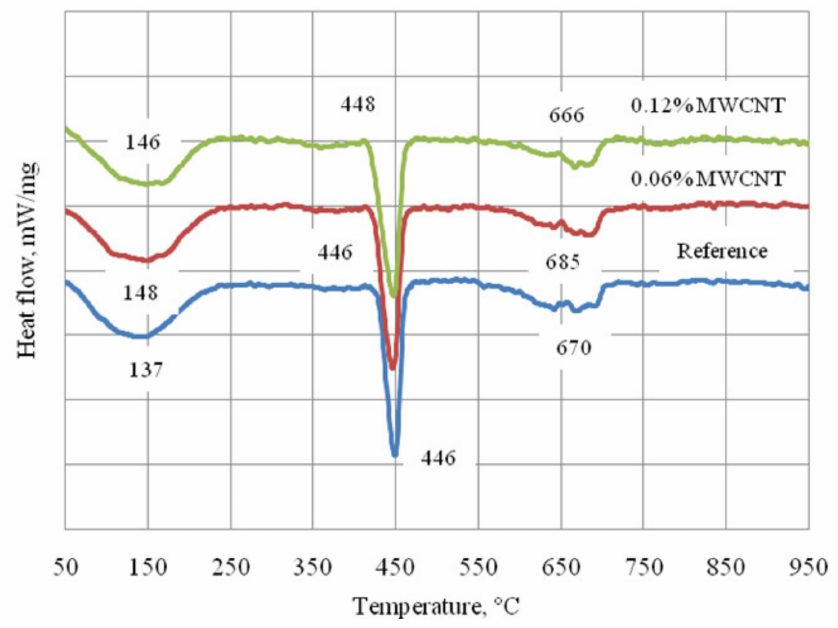
Figure 6. Differential scanning calorimetry patterns of samples with different amounts of the MWC- NTs cured for 28 days under normal conditions.